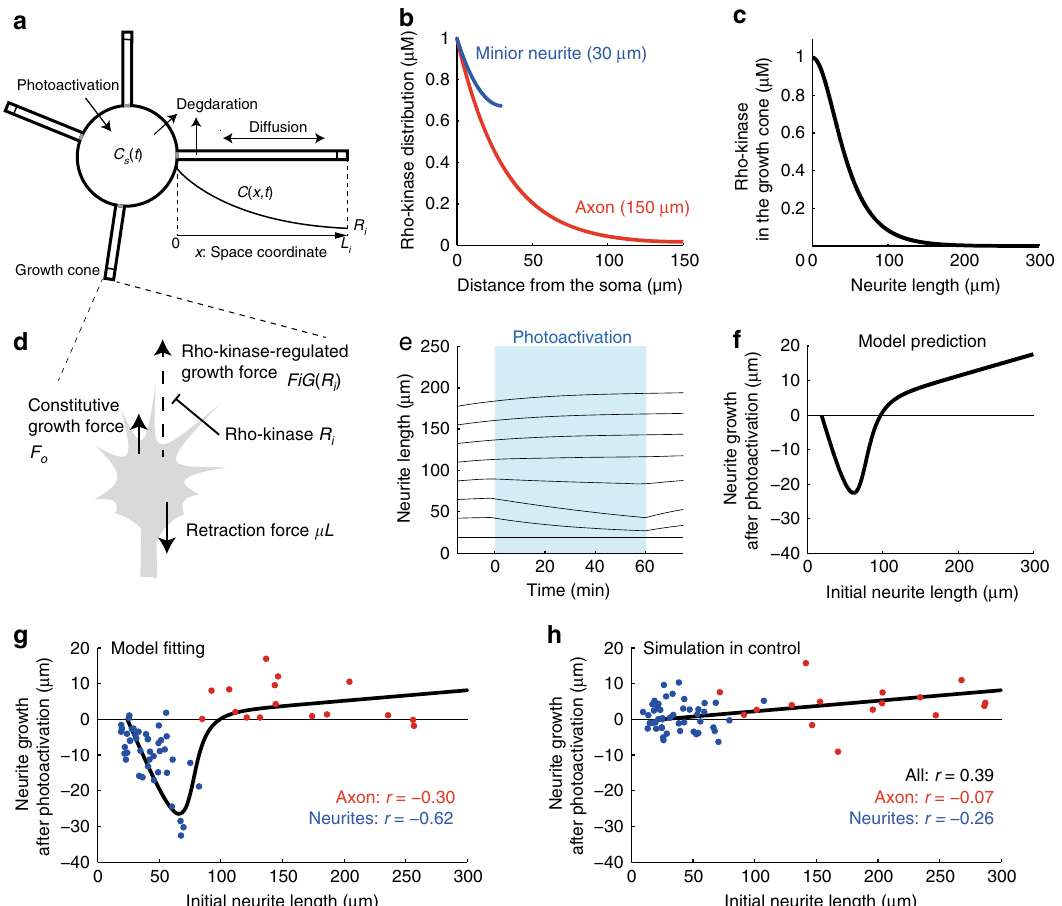
Fig. 4 Mathematical model for neurite outgrowth regulated by LOVTRAP-Rho-kinase. a The model neurite was modeled based on one-dimensional reaction-diffusion of LOVTRAP-Rho-kinase, which was activated in the cell body by illumination, diffused along the neurite, and was then inactivated or degraded. C s ( t ), C i ( x,t ) and R i indicate the concentrations of LOVTRAP-Rho-kinase in the cell body at time t , along the neurite at x μ m from the neck of neurite i at time t , and in the growth cone, respectively. b The steady state distribution of LOVTRAP-Rho-kinase along the long axon ( red line ) or the short minor neurites ( blue line ) during photoactivation. Equation (4) was plotted. c The concentration of LOVTRAP-Rho-kinase at the tip of the neurite depended on its length, which was mathematically described by Equation (1). d Migration of the model growth cone driven by constitutive growth force, Rho-kinase-regulated growth force and retraction force. e The simulation dynamics of neurites of various lengths in response to photoactivation of LOVTRAP-Rho-kinase. Red and blue lines represent typical behaviors of the long axon and short minor neurites, respectively. f Model prediction of the relationship between initial neurite length and LOVTRAP-Rho-kinase-dependent neurite retraction. The black line was plotted by varying F i , which controls initial neurite length. g , h The neurite retraction caused by a 1-h photoactivation of LOVTRAP-Rho-kinase g and LOVTRAP-Control h was plotted against the initial length of each axon ( red dots ) and minor neurite ( blue dots ). The black lines indicate the relationship generated by a simulation in which the parameters ( F o , K/C o , h , c ) were adjusted for the best fi t to the red and blue dots. The parameter values used are listed in